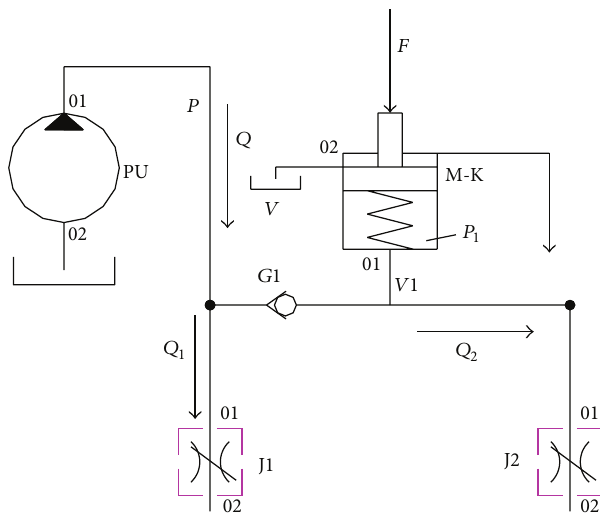
Figure 3: Working principle of the downhole drill string shock- absorption and hydraulic supercharging